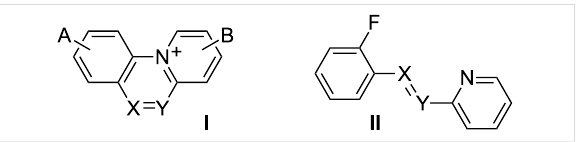
Figure 1: Structures of cations I and precursors II